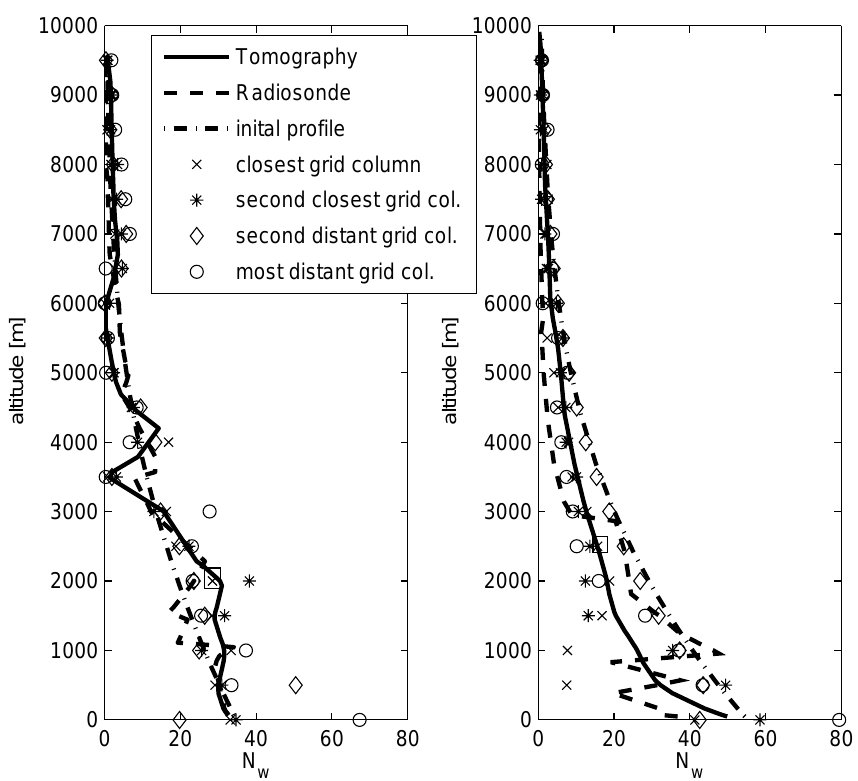
Fig. 5. Profiles on 31 January 2007, 12:00UTC, at station Bergen (left) and on 9 June 2007, 12:00UTC, at Schleswig (right). The grid cells indicated by the black boxes were chosen as examples as these cells are closest to the RS